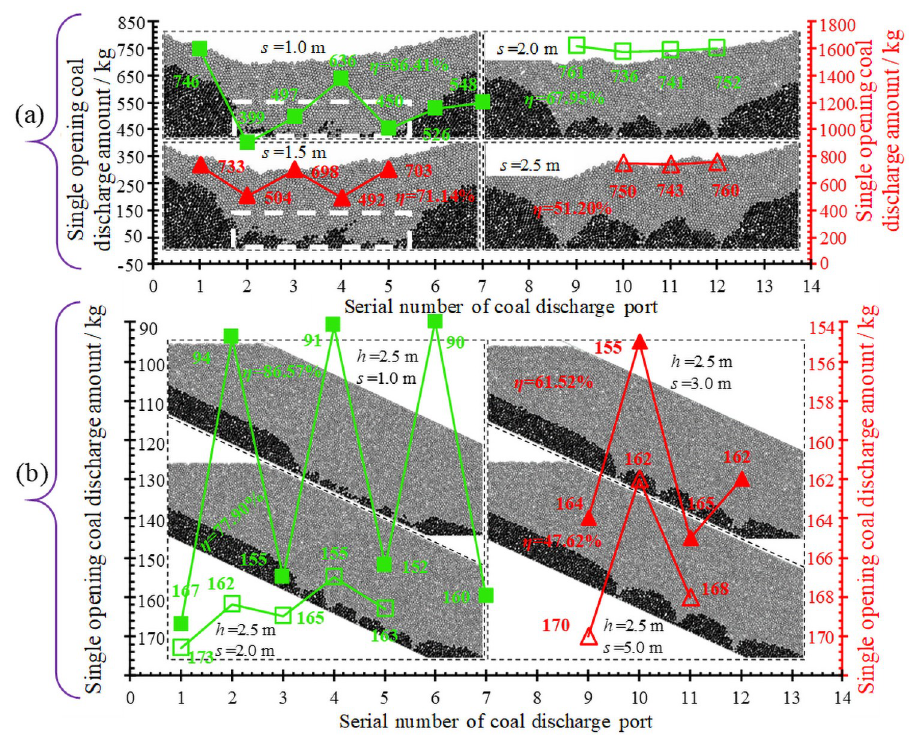
Fig 14. Stacking patterns of media at different coal caving distances. As shown in Fig (a), when the coal discharging interval is 1.0 m and 1.5 m, the fluctuation ranges of the coal discharging quantity of a single port is large, and the backside coal is piled into an inclined strip area, when the coal discharging interval is 1.5 m, the backside coal dispersion degree is smaller and the accumulation area is larger. When coal discharge distance is greater than 2.0 m, the fluctuation range of the coal discharge quantity of a single port is small, and there is almost no discrete state of back-coal, but the accumulation area is positively correlated with the coal discharge distance. For Bai-Ji mine, when the tailstock caving height is 6.51 m, the caving interval is 1.67 m. As shown in Fig (b), when the coal caving interval is 1.0 m, the fluctuation range of single coal caving is large, and the back coal is relatively discrete. When the distance of coal caving is 2.0 m, 3.0 m, and 5.0 m, the fluctuation range of single coal caving is small, and there is almost no discrete state of back coal. Consistent with the tailstock caving, the stacking area of back coal is positively correlated with the caving distance. For Bai-Ji Coal Mine, when the caving height of the working face is 2.23 m, the drawing interval of coal is more reasonable at 1.40 m.